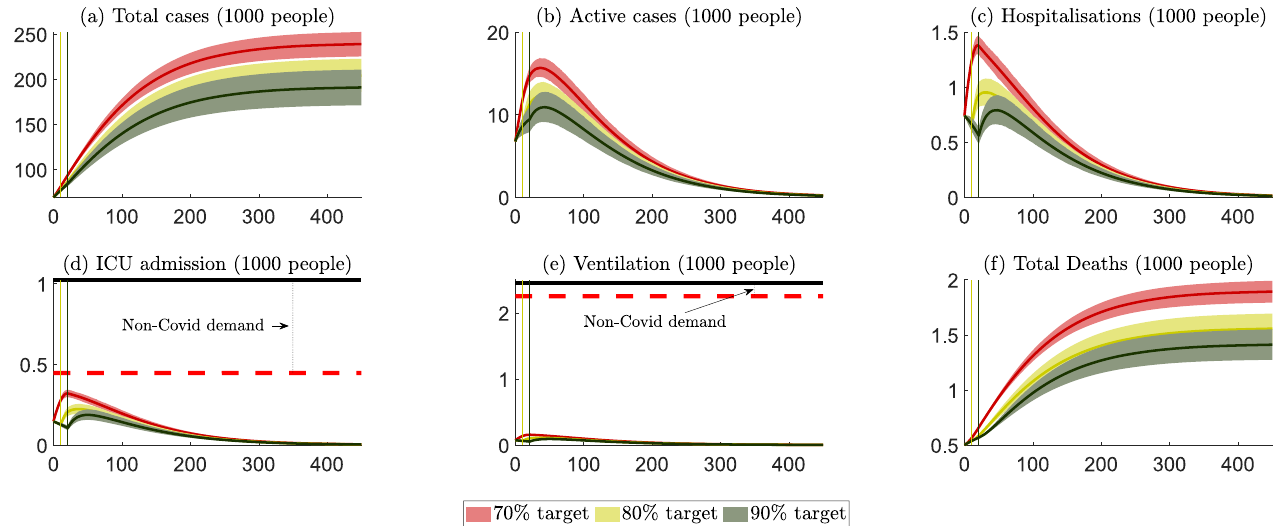
Fig 2. NSW: Projected public health outcomes after opening up. Notes about Fig 2: 1. Day zero is specified to be 11 October 2021. 2. The red, yellow, and green colours represent scenarios where lockdowns are removed after the 70%, 80% and 90% targets, respectively. 3. The (red, yellow, and green) vertical lines represent the days when the 70%, 80% and 90% targets are reached. 4. The (red, yellow, and green) curves represent the mean of all projection outcomes, and the bands represent their 95% confidence intervals. 5. The black horizontal lines in panels (d) and (e) are the capacity of the health care system, i.e., staffed ICU beds and ventilators (data sources reported in S1 Text). 6. The red horizontal dashed lines in panels (d) and (e) are the net capacity of the non-COVID19 ICU and ventilation demand, which are estimated via the occupation rates of ICU beds and ventilators in 2018/2019 (data sources reported in S1